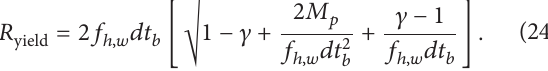
Nm), for the Ply- = 9.09 kN yield = 20.4 plate